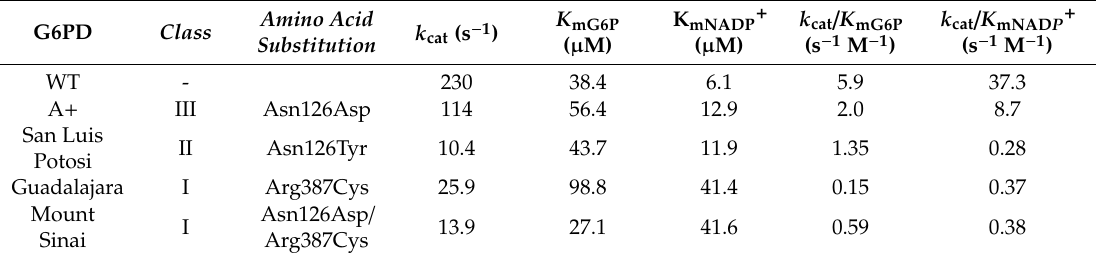
Table 2. Summary of kinetic parameters of WT G6PD and four G6PD mutants.